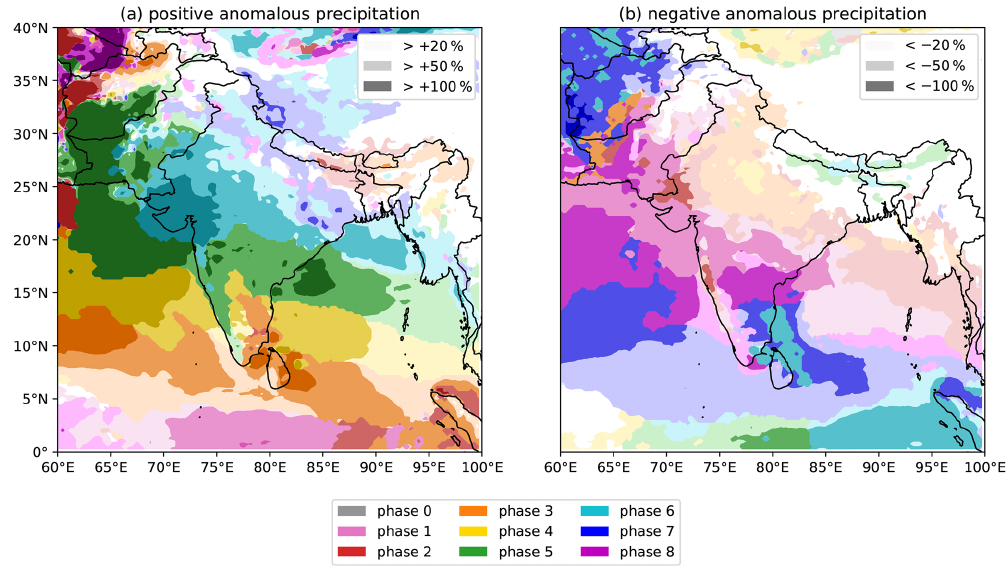
Figure 1. The effect of the BSISO on monsoon precipitation over South Asia. Colours indicate the BSISO phase for which mean precipitation is (a) the highest and (b) the lowest. Three levels of lightness for each colour denote the difference between the mean precipitation in that phase and the full climatology, stratified at ± 20%, ± 50%, and ± 100%. A colourblind-friendly version of this figure, with the anomalies plotted separately for each BSISO phase, is given in Fig. S1 in the Supplement.